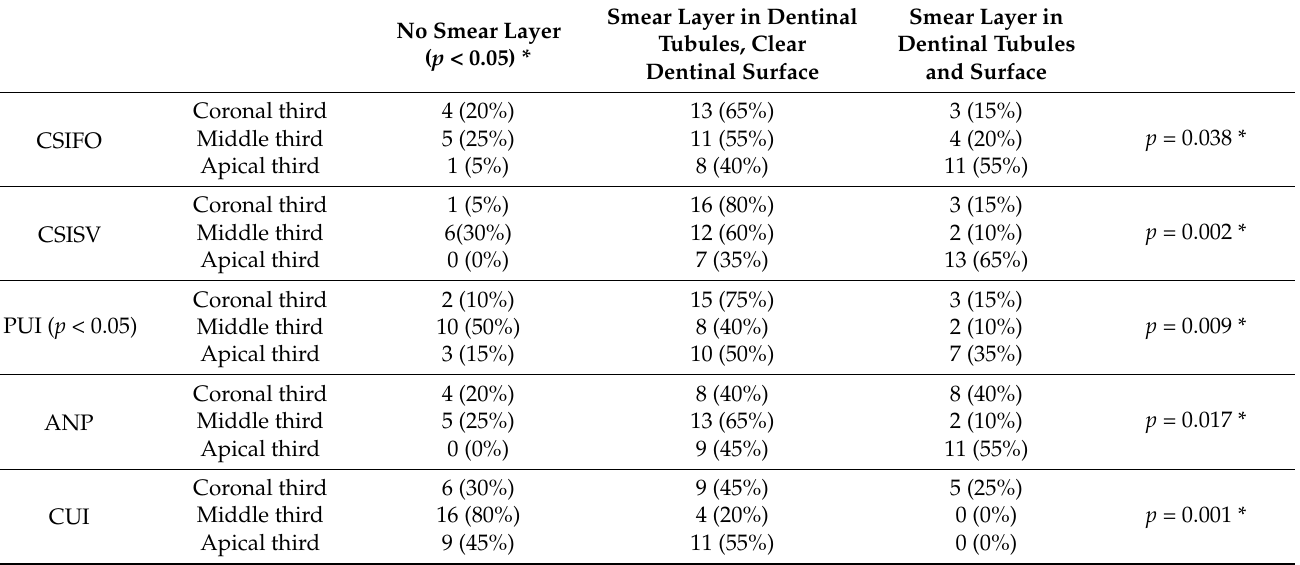
Table 1. Number of specimens and percentage regarding the smear layer scores in the root thirds of all experimental